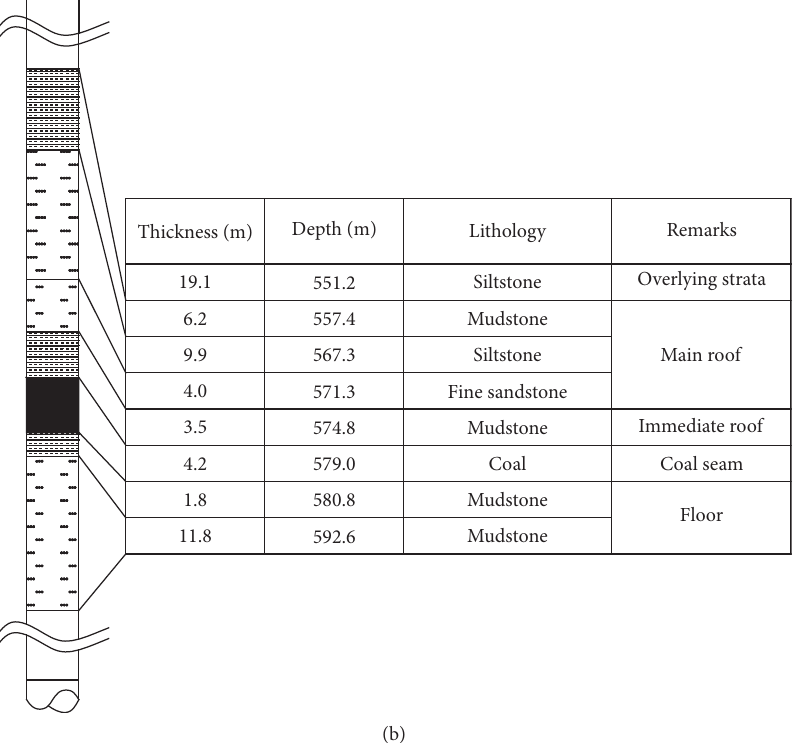
Figure 9: General mining and geology conditions of the #1301 working face in Licun Coal Mine. (a) Excavation plan of the #1301 working face. (b) Comprehensive column chart of the coal seam and roof and floor of the #1301 working